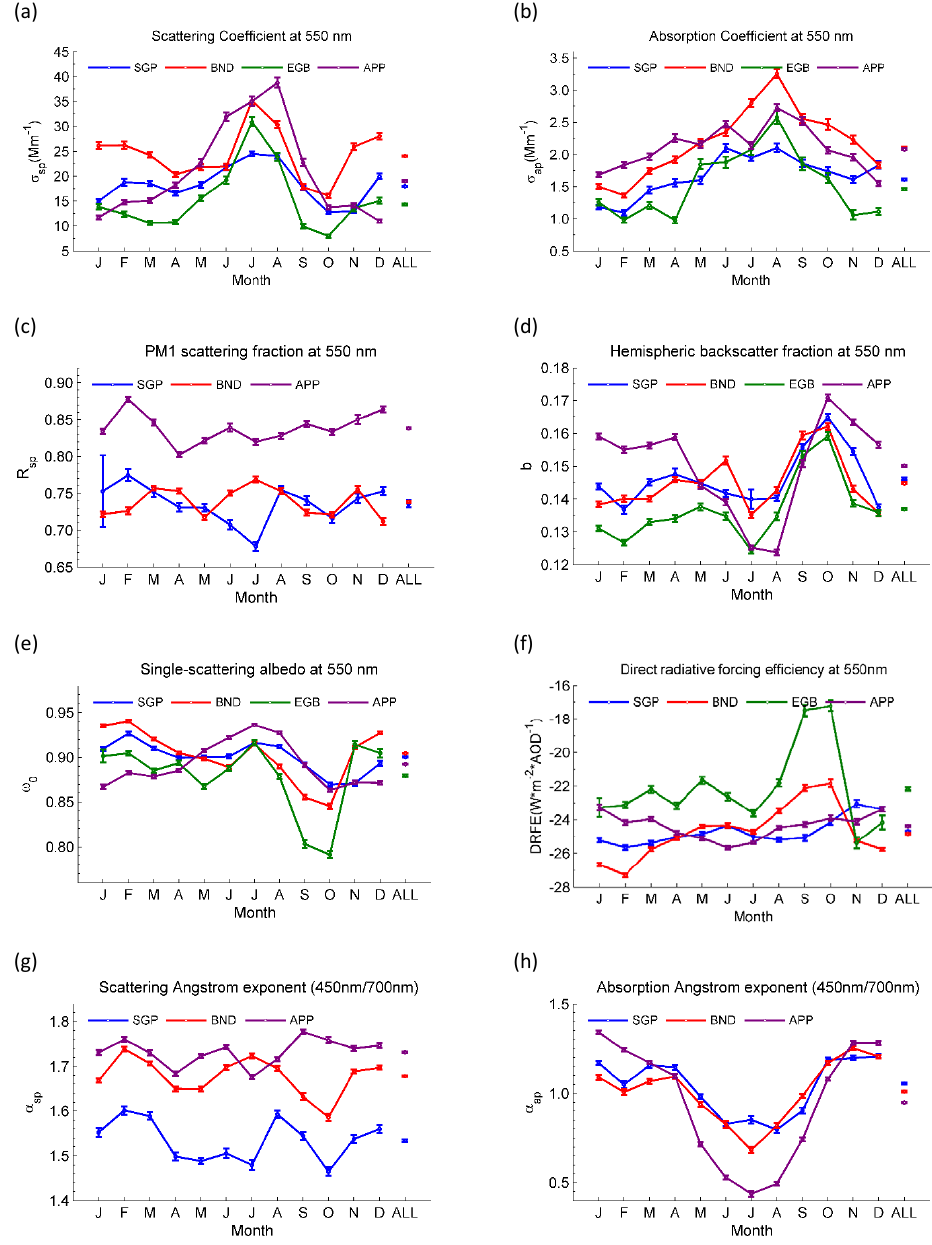
Figure 2. Annual cycle of (a) geometric mean PM 1 σ sp ; (b) geometric mean PM 1 σ ap ; (c) mean R sp ; (d) mean PM 1 b ; (e) mean PM 1 ω 0 ; (f) mean PM 1 DRFE; (g) mean PM 10 α sp (450/700nm); and (h) mean PM 1 α sp 450/700nm) at APP, BND, EGB, and SGP over the 2010–2013 period. The values corresponding to “ALL” are geometric mean or mean values for the entire 2010–2013 period (all months). Error bars represent 95% confidence intervals of the mean